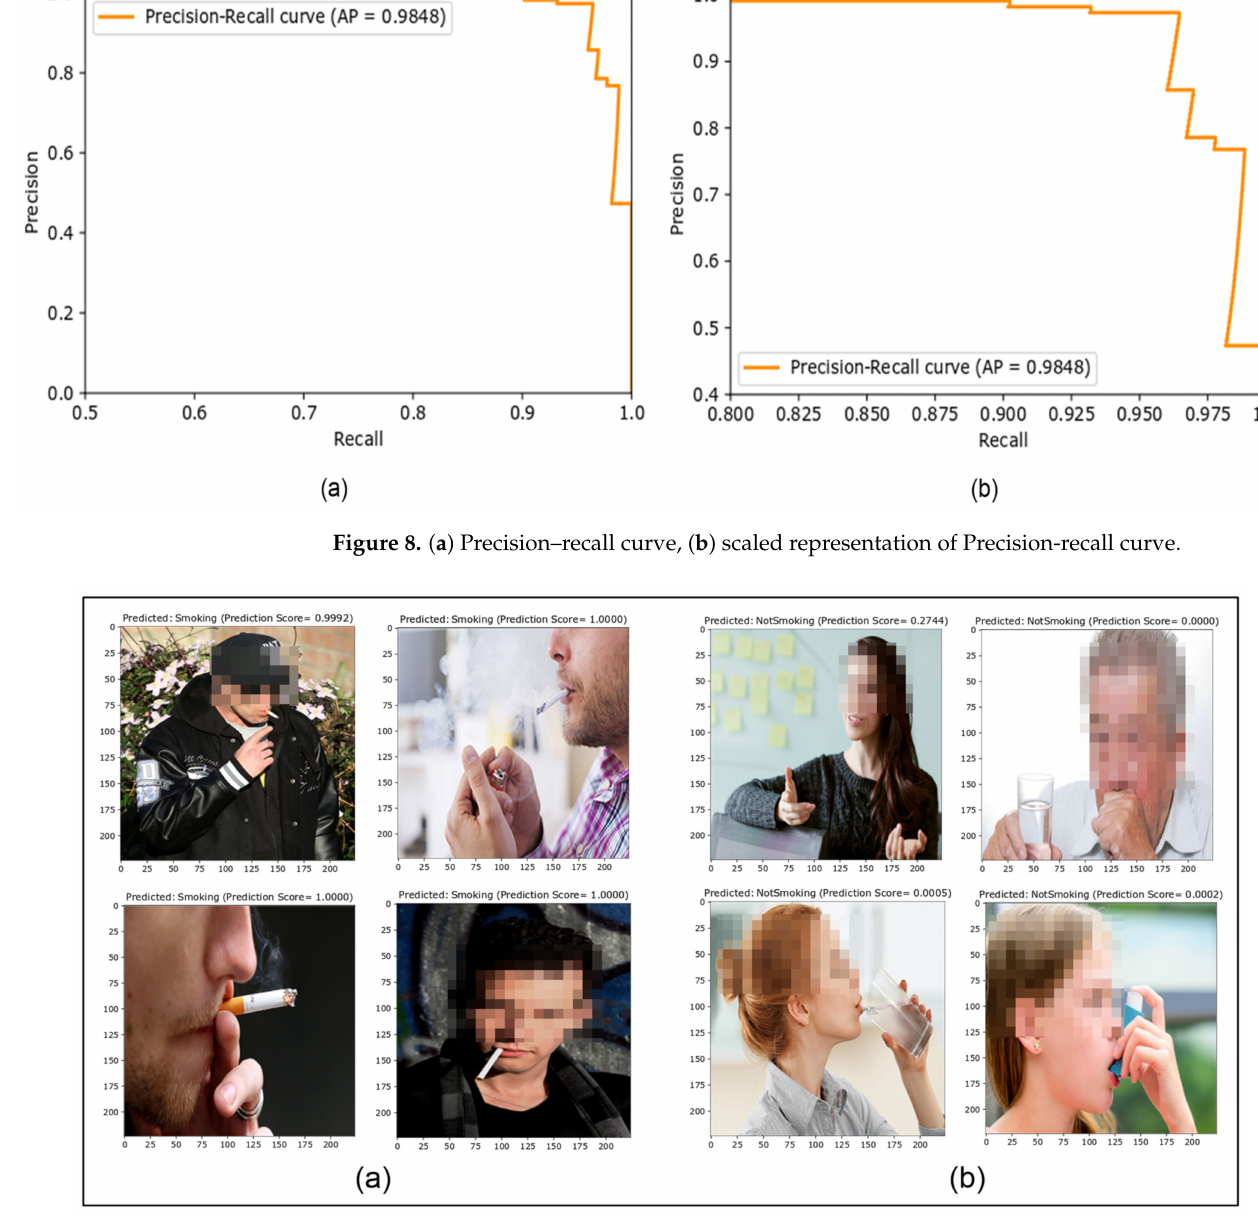
Figure 9. True prediction ( a ) positives and ( b ) negatives. False